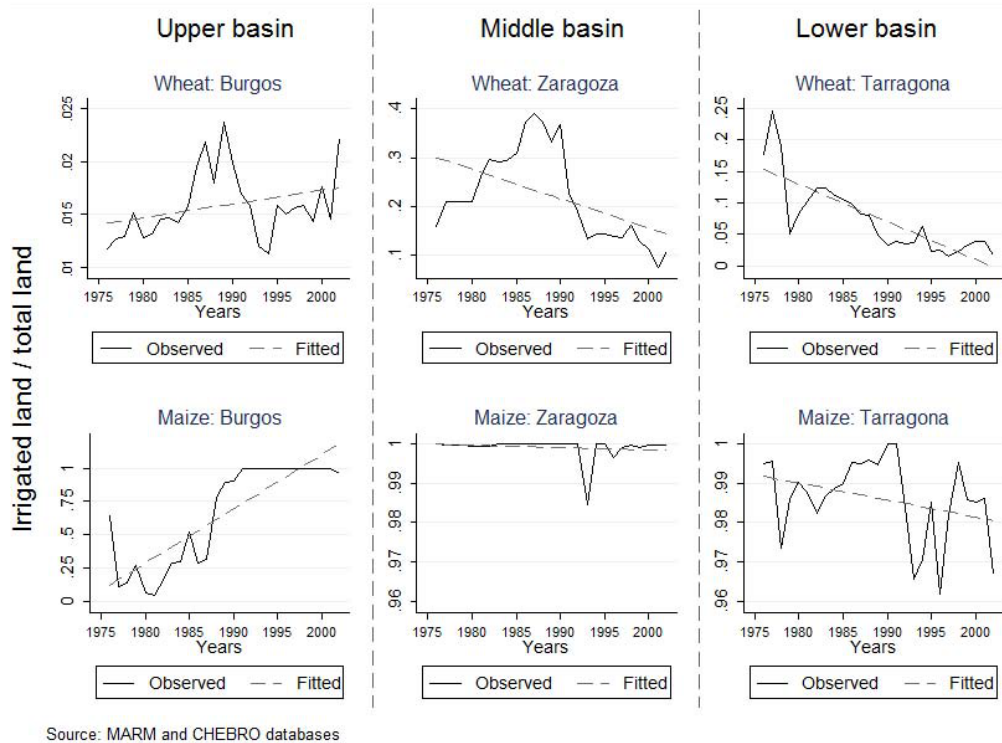
Fig. 4. Irrigated land for wheat and maize at representative areas of Upper (Northern, Central and Low Ebro: Burgos, Zaragoza and